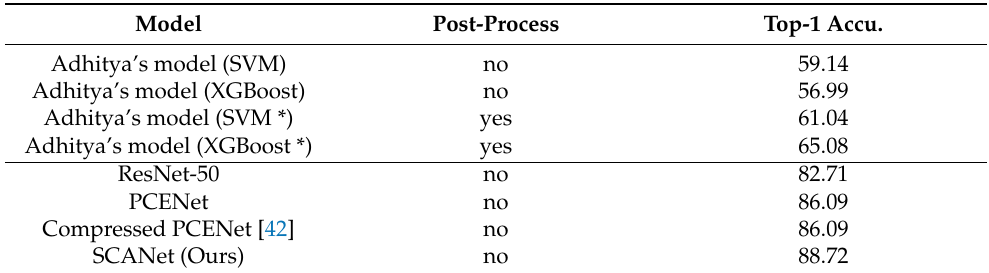
Table 4. Comparison of the classification results using cocoa bean dataset. The visual feature enhancement employing GLCM scheme for post-processing [41] is shown by